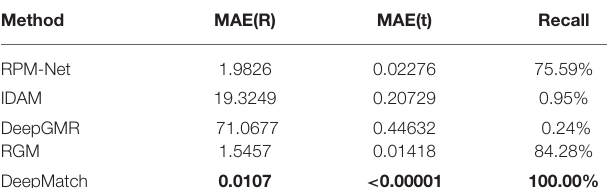
TABLE 3 | The performance of different methods on unseen categories of point clouds.